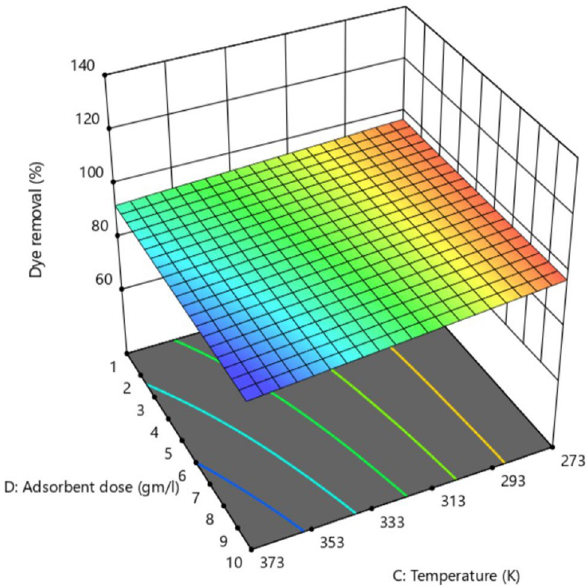
Fig. 21 Surface view showing the relation relative variation of per- centage dye removal with adsorbent dose and